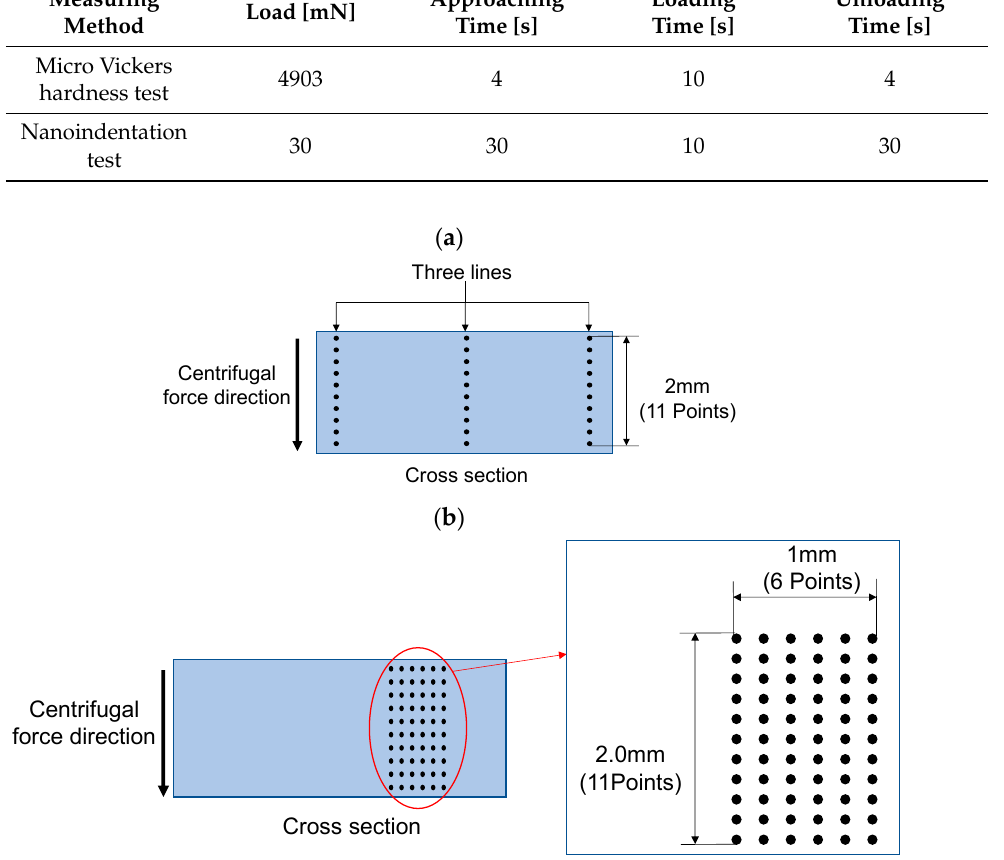
Table 1. Conditions for Micro Vickers hardness test and nanoindentation test.